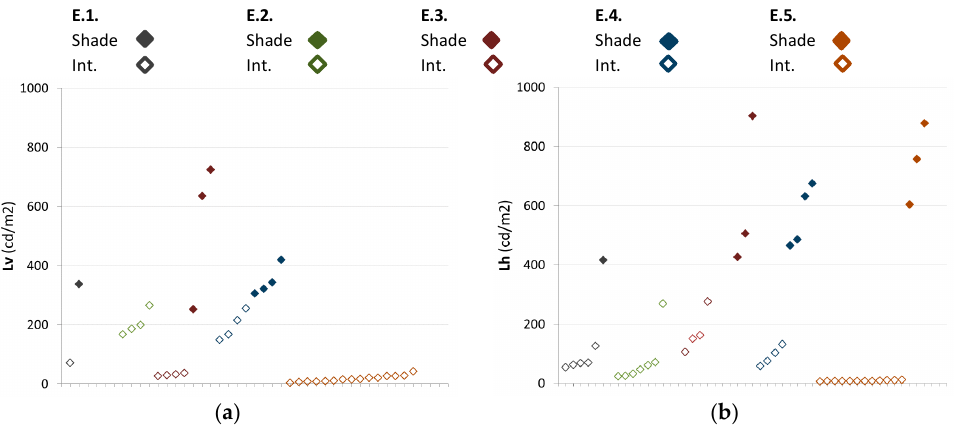
Figure 4. ( a ) Interior and outside shaded points’ luminance (cd/m 2 ) in Zone 2; and ( b ) interior and outside shaded points’ luminance (cd/m 2 ) in Zone 1 for Cases E.1–E.5.